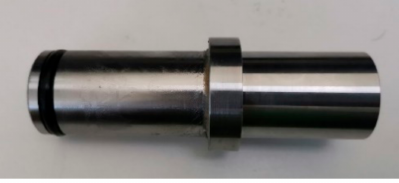
Figure 11. The piston.